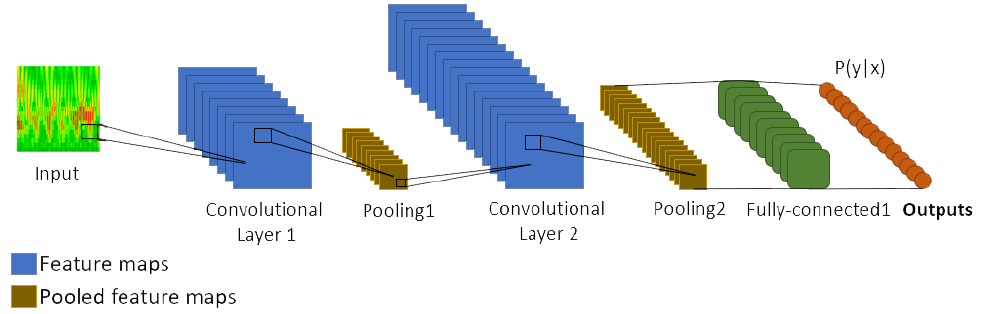
Figure 4. Common architecture of a Convolutional Neural